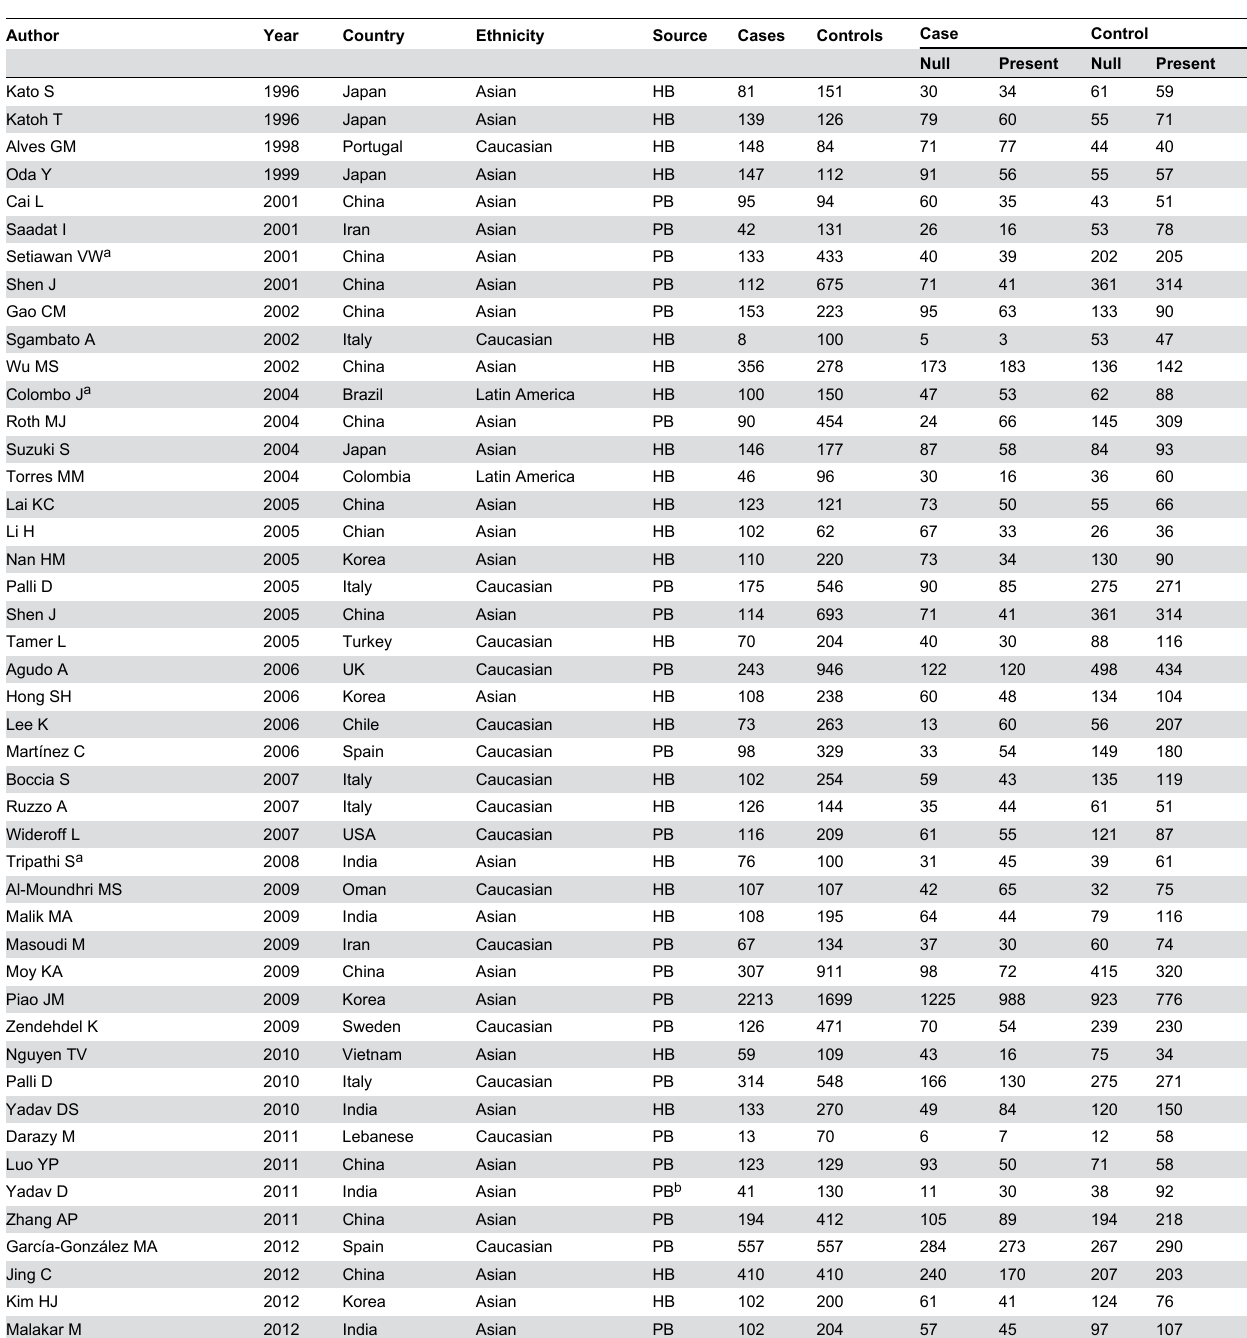
Table 1. Baseline characteristics of eligible